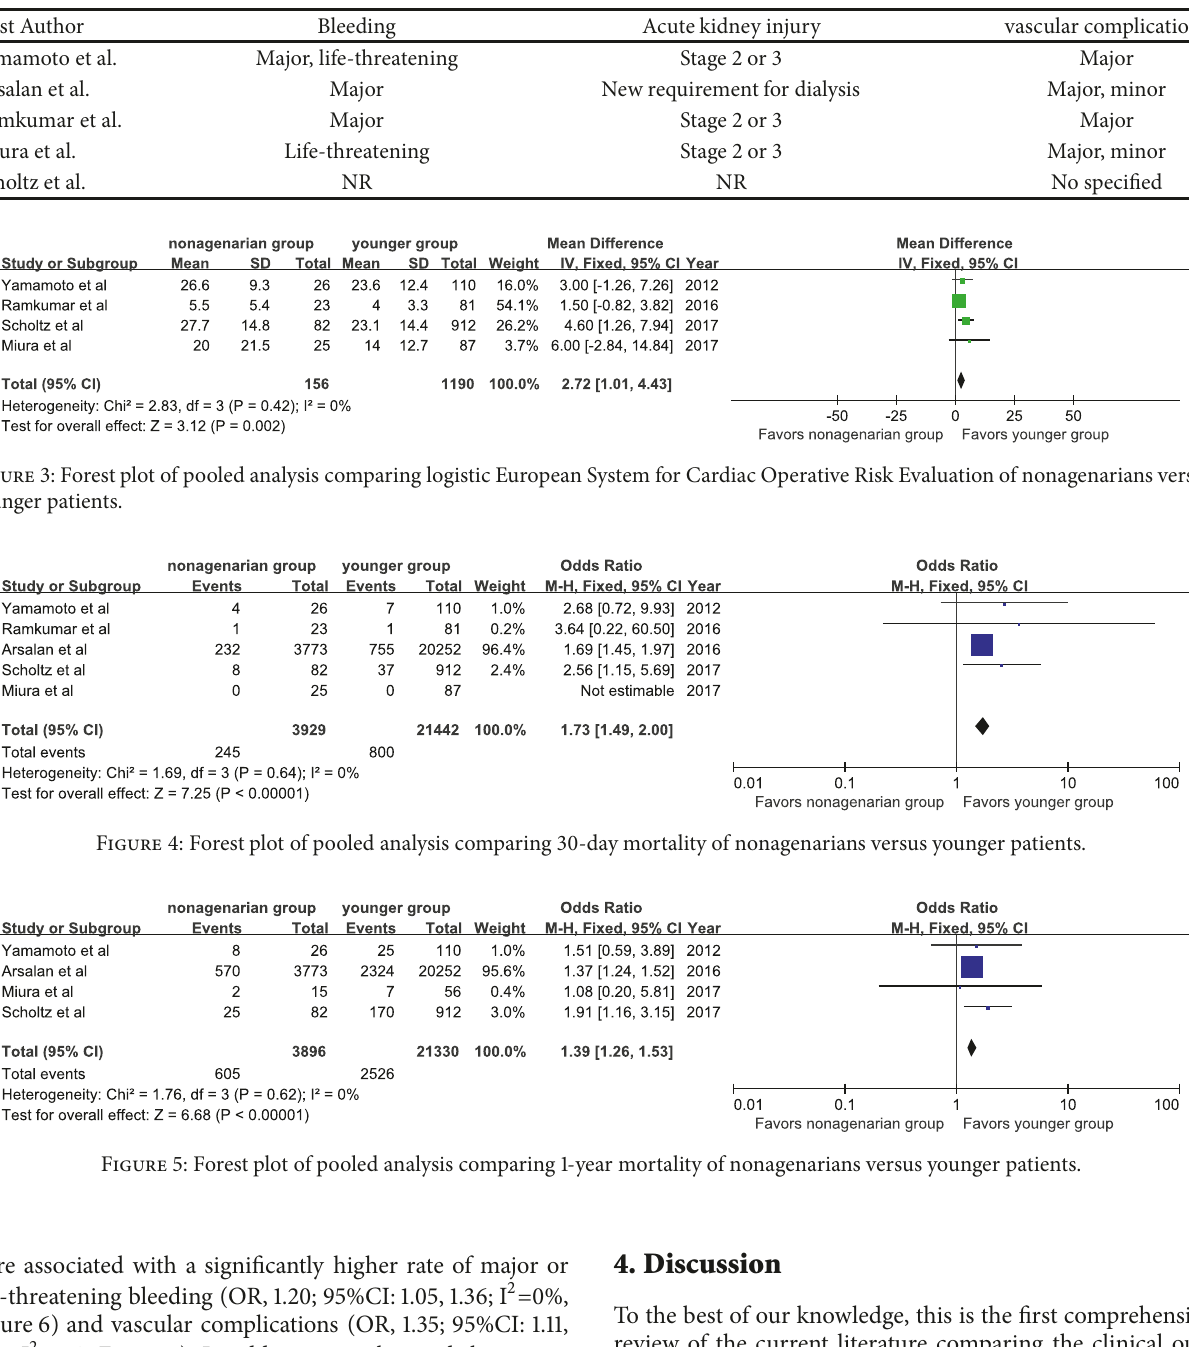
Table 3: The specific definitions of bleeding, acute kidney injury, and vascular complications.